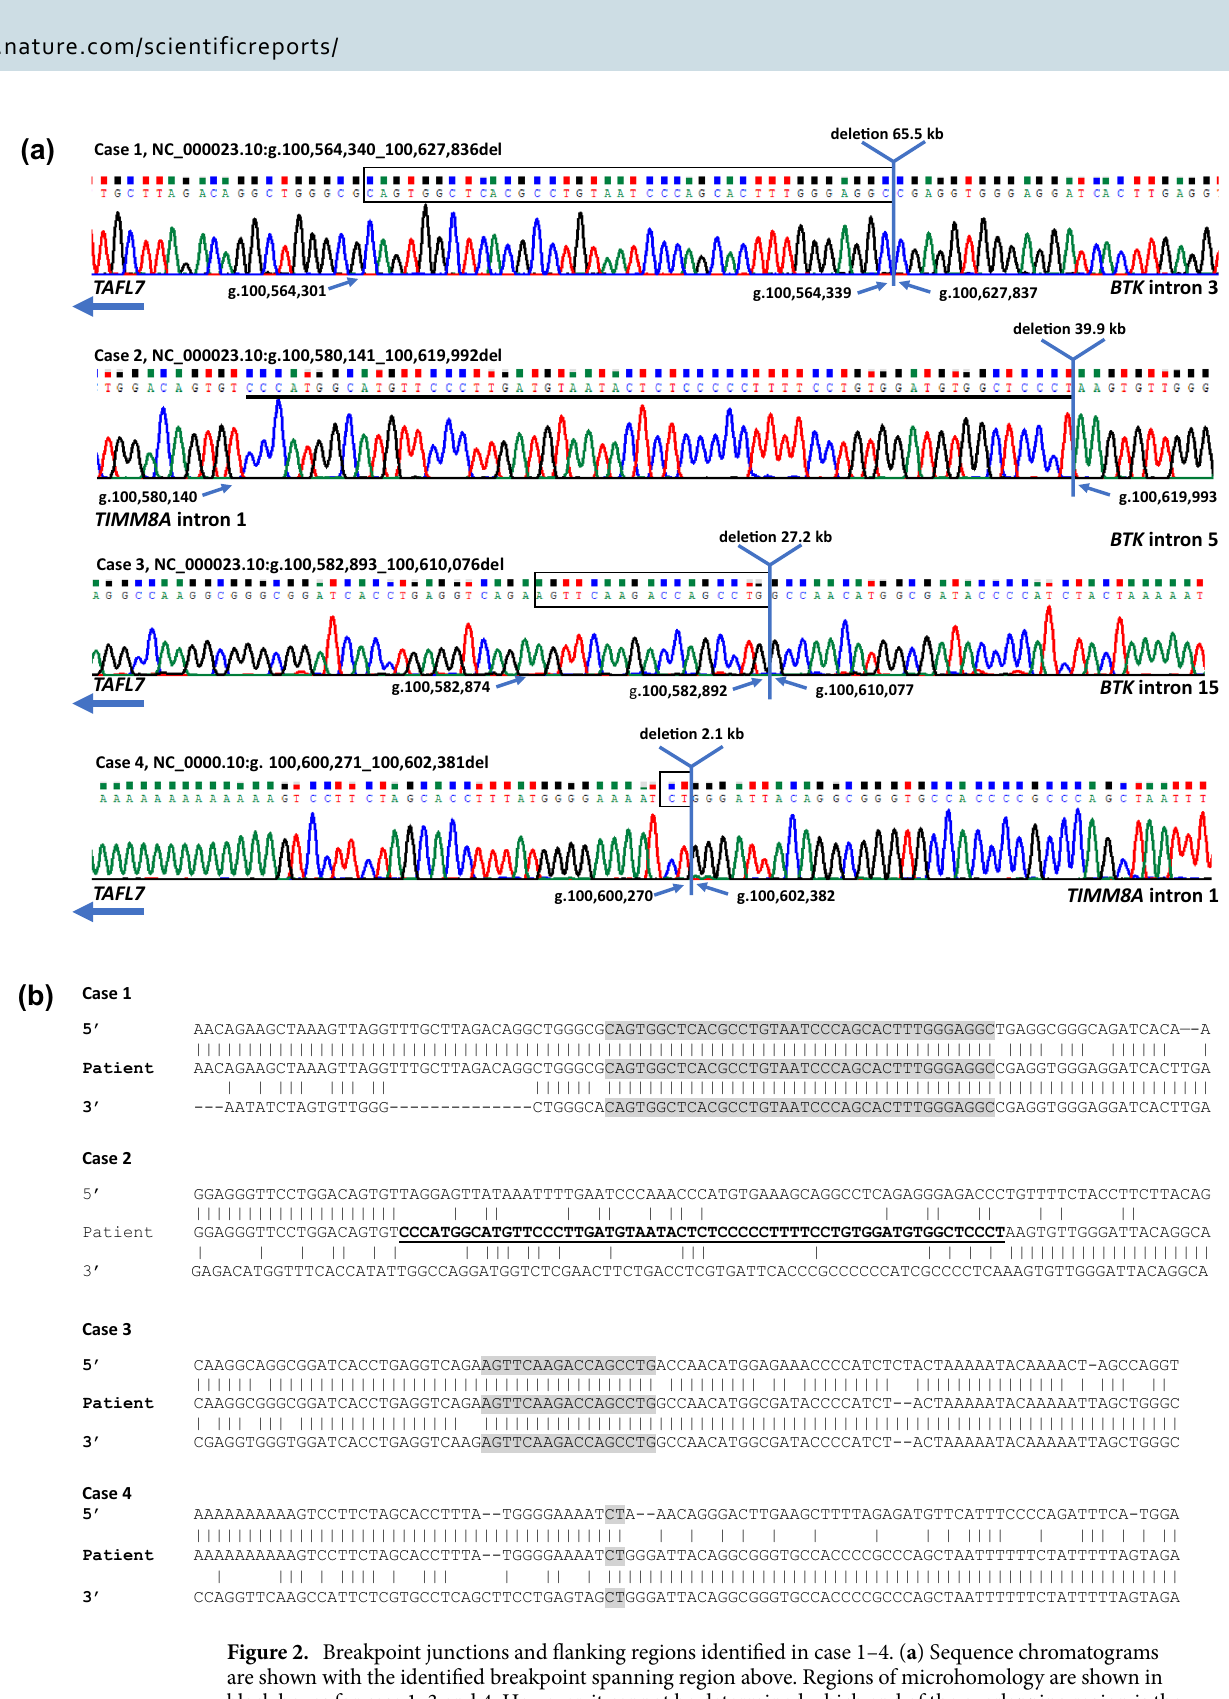
Figure 2. Breakpoint junctions and flanking regions identified in case 1–4. ( a ) Sequence chromatograms are shown with the identified breakpoint spanning region above. Regions of microhomology are shown in black boxes for case 1, 3 and 4. However, it cannot be determined which end of the overlapping region is the real breakpoint. The 59 bp inverted insertion identified in the breakpoint region in case 2 is underlined. ( b ) Sequences of the identified breakpoint junctions in case 1–4 compared to upstream and downstream references sequence. Regions of microhomology are shown in